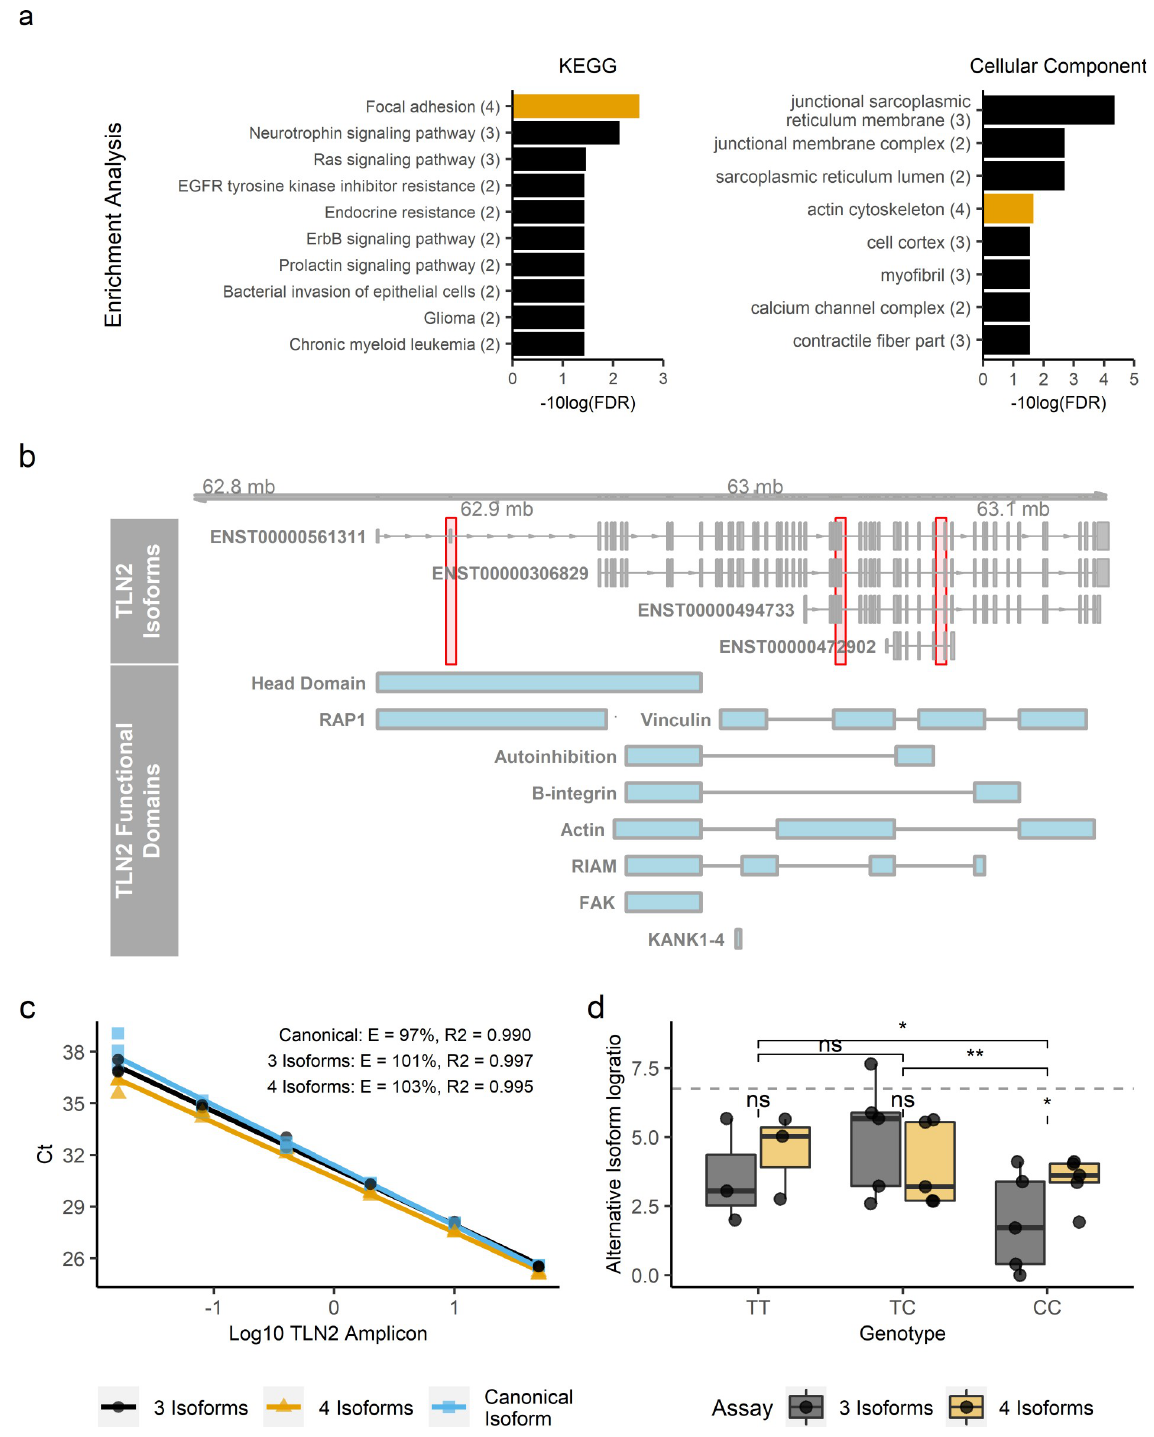
Fig 4. TLN2 , functioning in cell adhesion and structure, exhibits genotype-specific alternative transcription. a, Select ontological terms that were enriched in this study. See S2 Table for a full list of terms. Terms involving TLN2 are colored yellow and number of included genes (out of 15 total included in testing) per term is given in parentheses next to each term. b, Distribution of TLN2 protein coding transcripts on human chromosome 15 with functional domains illustrated per Gough and Goult 2018. Red shading, from left to right denotes the transcript regions amplified from either the canonical isoform, three isoform, or four isoform assay used to compare alternative transcription by genotype (see Methods). c, Standard curve of RT-qPCR assays, with calculated efficiencies shown per assay. d, TLN2 log isoform ratios